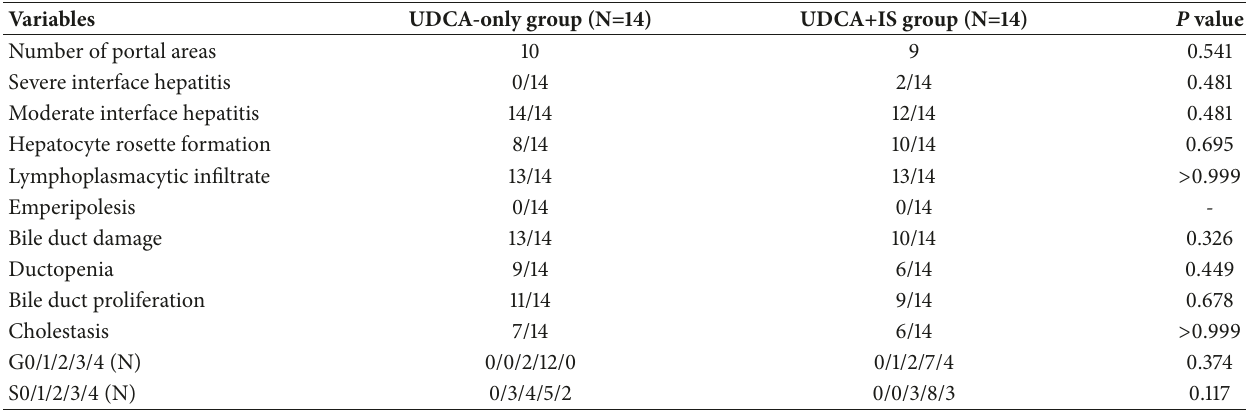
Table 3: Histological features of the decompensated PBC-AIH